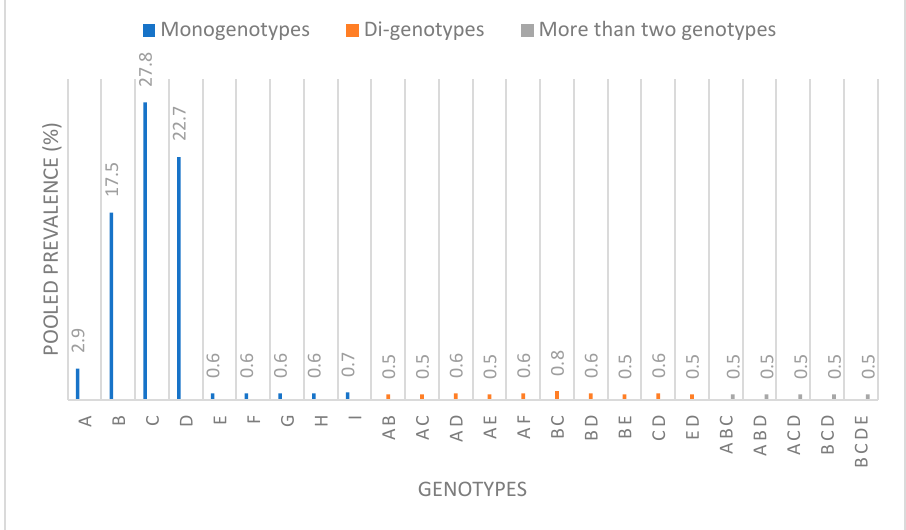
Figure 3. A chart showing the pooled prevalence of HBV genotypes in Asia.